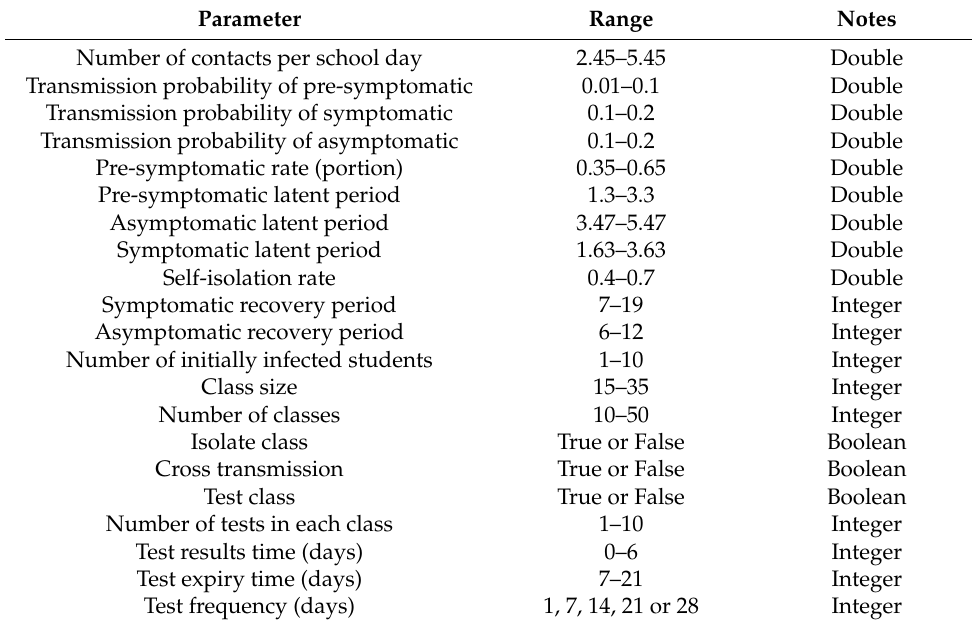
Table 1. Parameter ranges used for sampling in the data generation